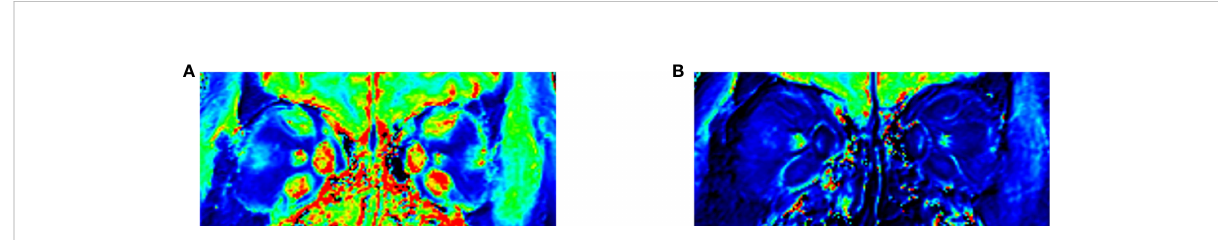
FIGURE 4 T1 mapping of EOMs. (A) Native T1 mapping. (B) Post-contrast T1 mapping for evaluating fi brosis in EOMs. Evaluating the T1 value or ECV of medial rectus and inferior rectus muscles may be suf fi cient for providing help for diagnosis. This fi gure is